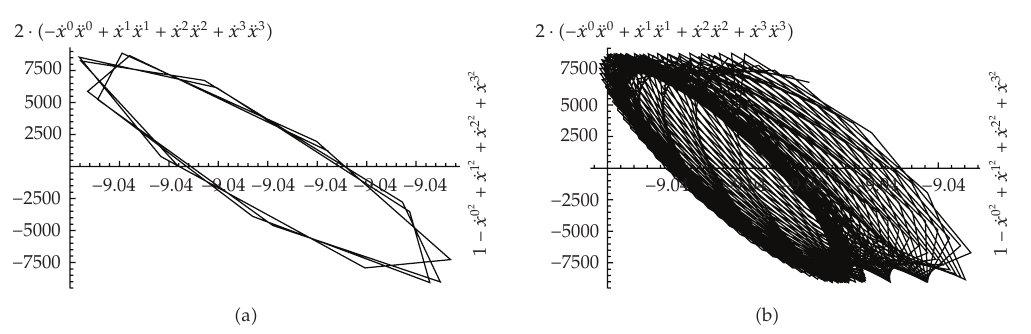
Figure 15: Time step: 10 − 12 GeV − 1 . The scale is about 13 times smaller than the one in Figures 14 (cid:6) a (cid:7) and 14 (cid:6) b (cid:7)